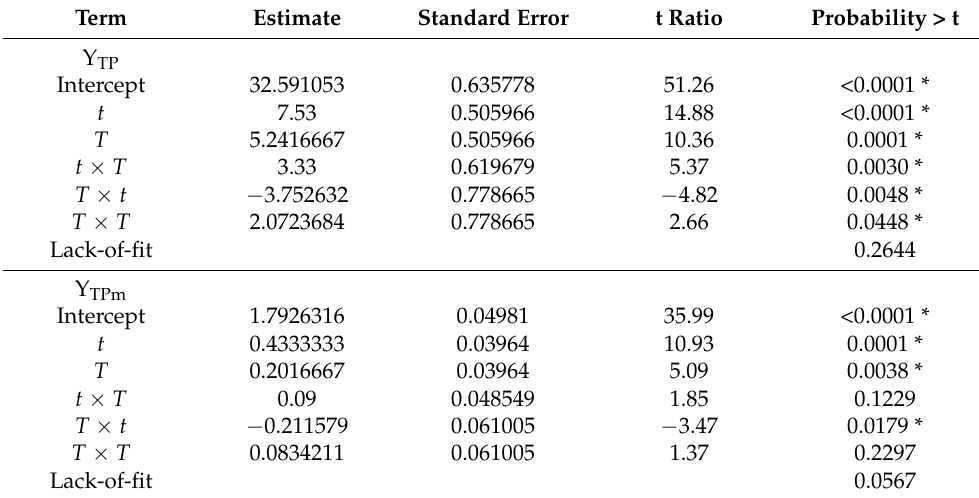
Table 2. Statistical information related to the mathematical models, generated using response surface methodology.